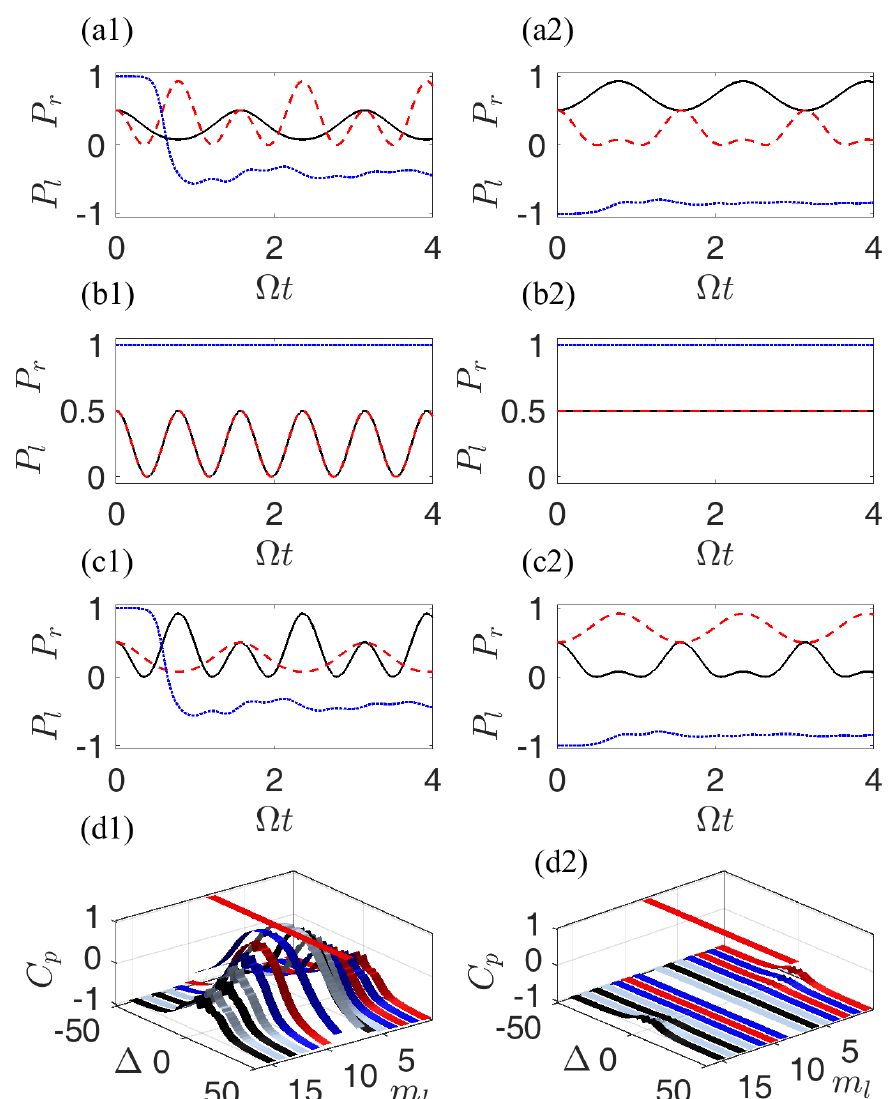
Figure 5. Calculated dynamics for the initial states of | ψ + (cid:105) (left column) and | ψ − (cid:105) (right column), respectively. Time evolutions of collective Rydberg excitation probabilities P l (solid black curve), P r (dashed red curve) and Pearson correlation (dotted blue curve) coefficient C p under three sets of parameters: ( a1 , a2 ) ( m l , m r ) = ( 1,15 ) ; ( b1 , b2 ) ( m l , m r ) = ( 8,8 ) ; ( c1 , c2 ) ( m l , m r ) = ( 15,1 ) ; ( d1 , d2 ) Pearson correlation coefficient C p as a function of the single-photon detuning ∆ and the number of atoms m l with total atom number m = 16 for the evolution time Ω t = 4 in the last row. Other parameters are given at the beginning of Section